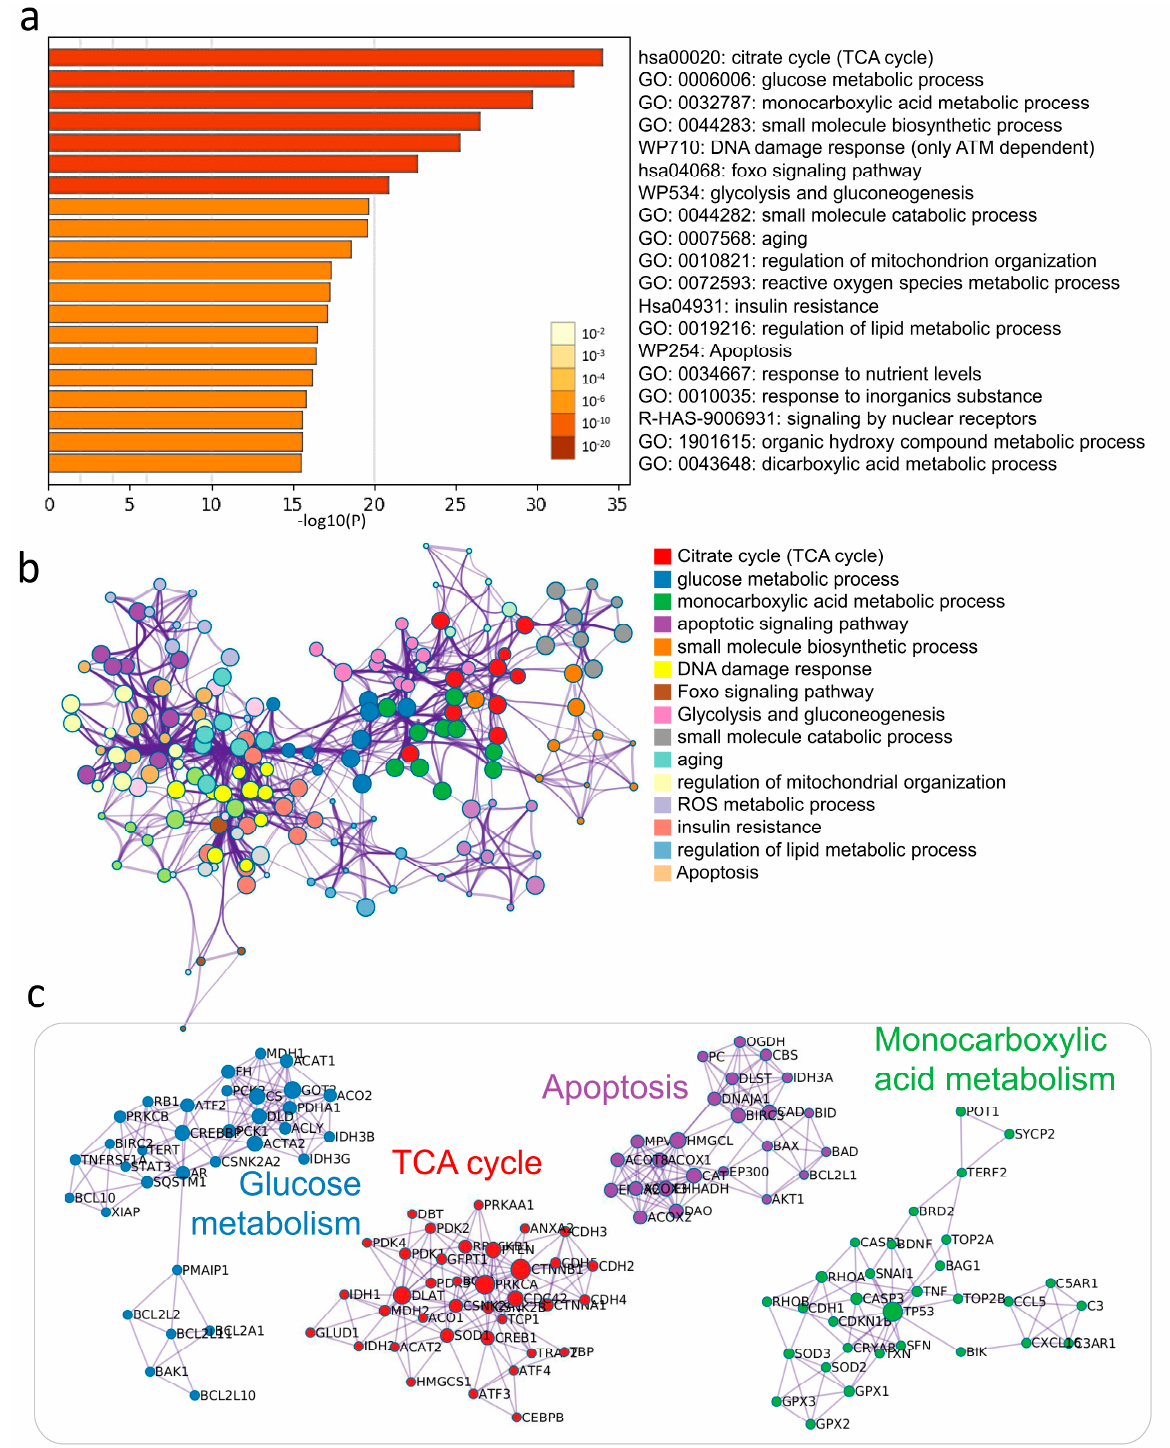
Figure 2. Supplementation with DHEA regulates potential metabolic pathways in the cumulus cells of elderly infertile patients. ( a ) Functional enrichment analysis of DEGs. The bar graph shows the top 20 results of the enrichment analysis of DHEA altered aging genes. ( b ) Networks of enriched protein-protein interactions for the same input list. ( c ) Biological pathways are significantly enriched in aging CCs response genes regulated by